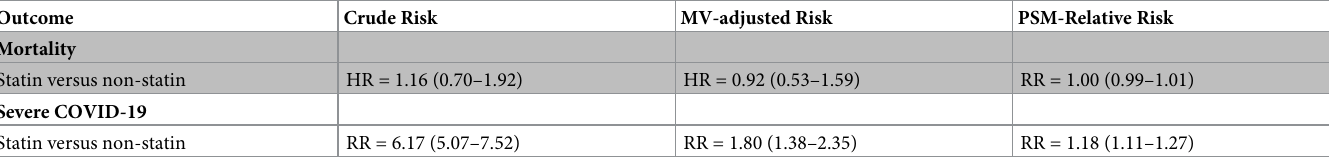
Table 4. Risk for mortality and severe COVID-19 infection in statin users versus statin non-users.